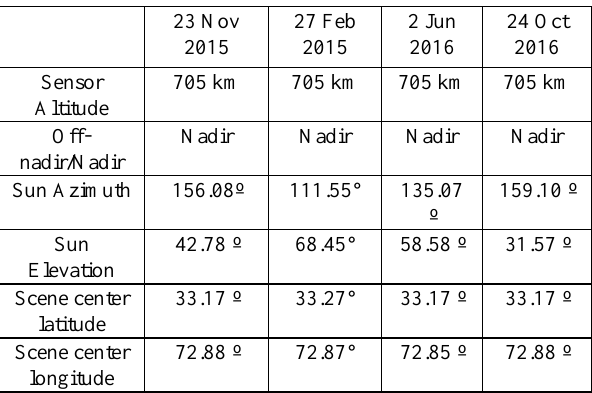
Table 1 : Imaging geometry conditions and scene center latitudes and longitudes for Landsat-8